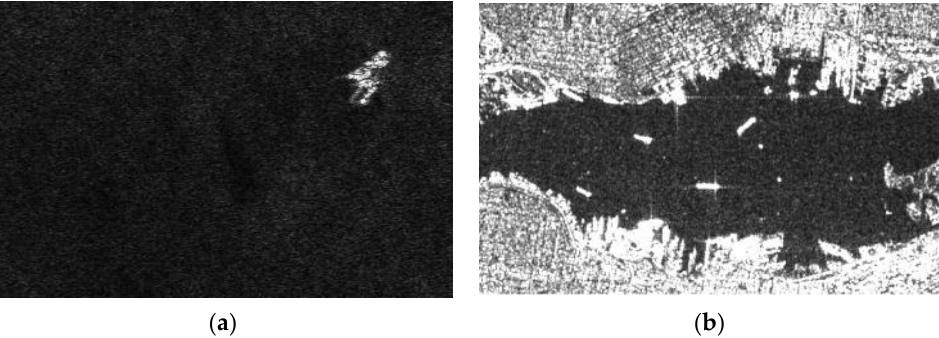
Figure 10. SAR images under two different sea conditions. ( a ) Shows the SAR image of the far-sea condition; ( b ) Shows the SAR image of the offshore sea condition.